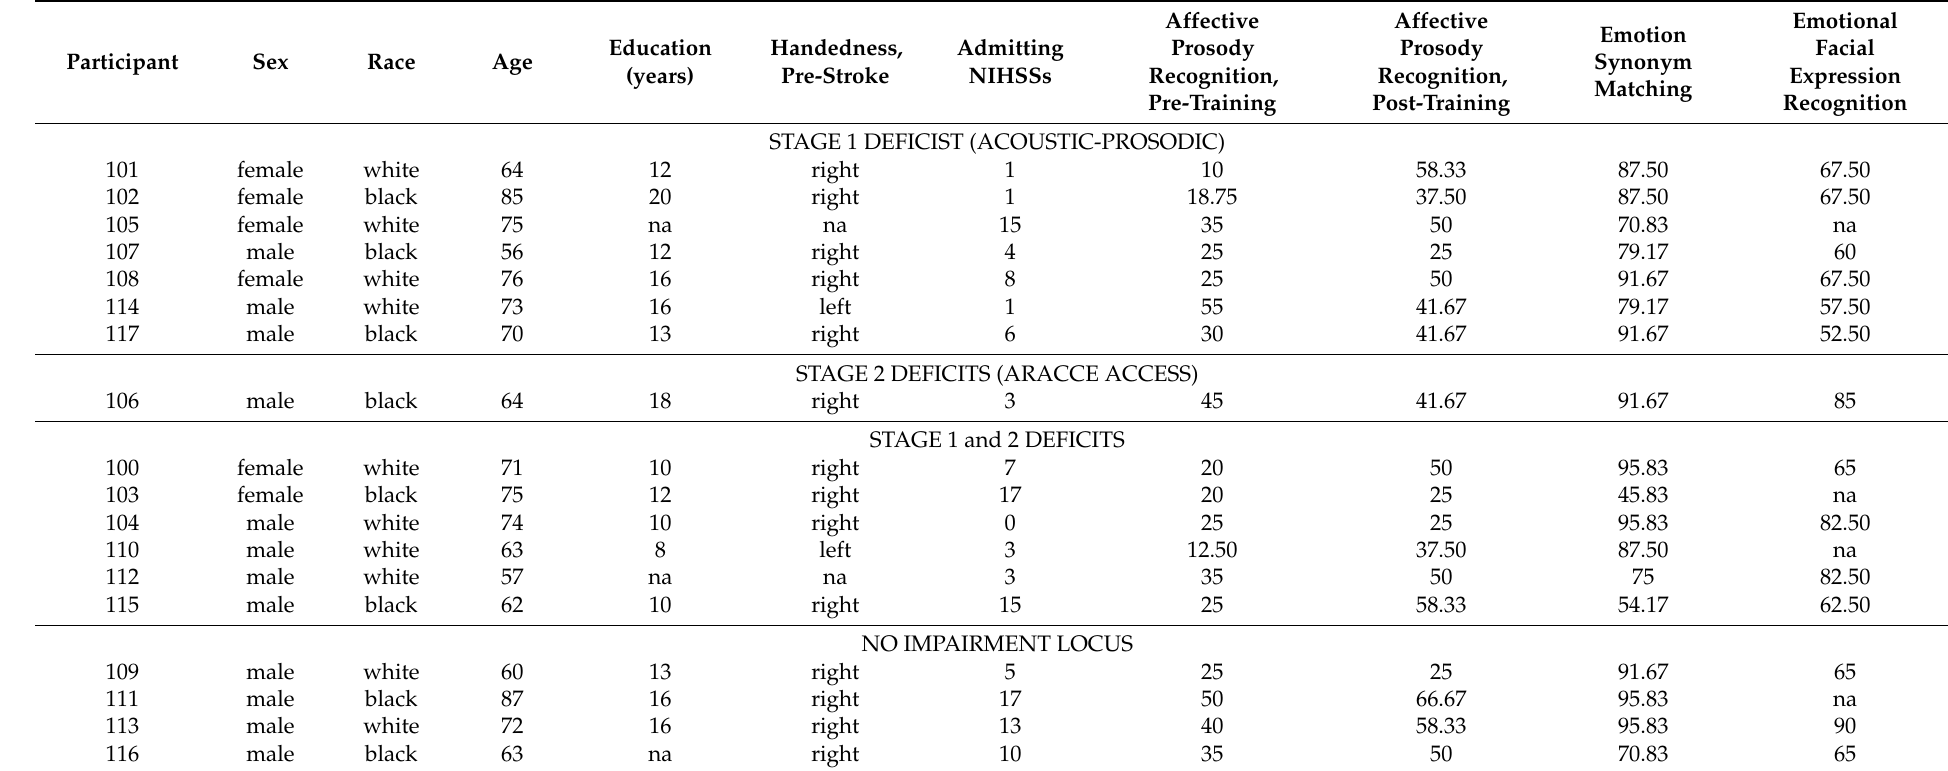
Table 1. Demographic and emotion recognition accuracy (%) of participations with acute RHD and receptive